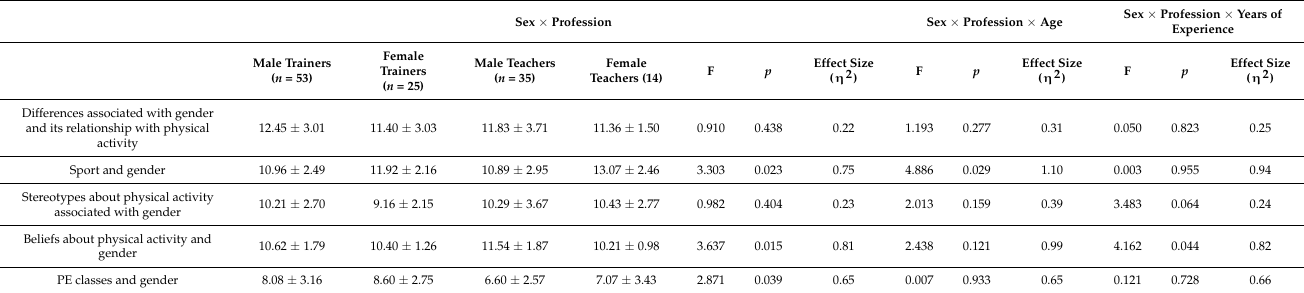
Table 2. Differences in gender stereotypes present in male trainers, female trainers, male teachers, and female